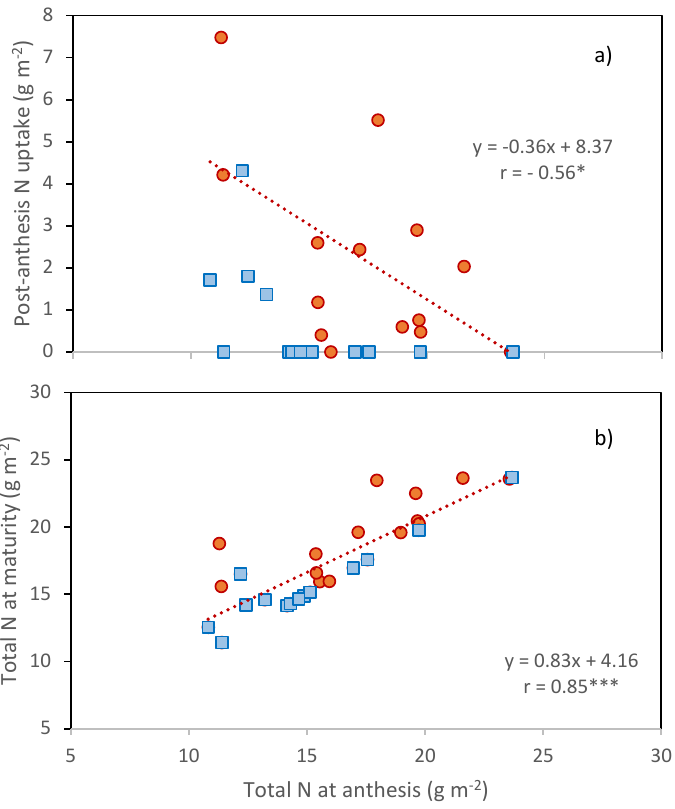
Figure 3. ( a ) Relationship between post-anthesis N uptake and N at anthesis; ( b ) Dependence of N present in crops at maturity on the N in the crop at anthesis. Data are C × Y means: Orange circles, 2016; blue squares 2017. Regression lines and equations refer to 2016 season. *, Pearson correlation coefficient significant at p ≤ 0.05; ***, Pearson correlation coefficient significant at p ≤ 0.001.